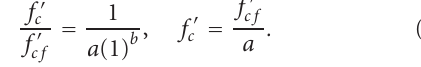
Figure 7: Proposed stress-strain curves of fiber aerated lightweight